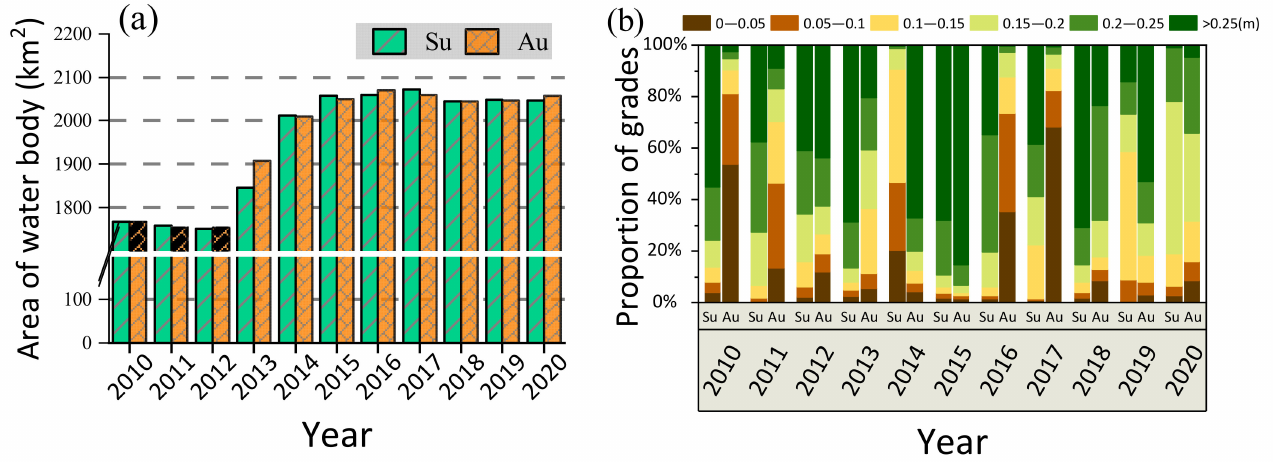
Figure 5. Temporal characteristics of transparency in Hulun Lake from 2010 to 2020.